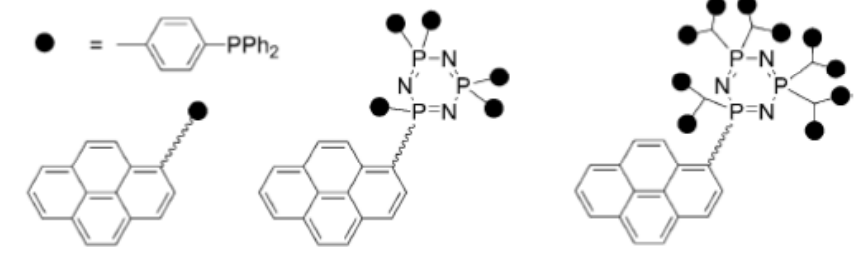
Figure 4. Structures of dendritic phosphine ligands. Reproduced from M. Keller et al . [55]. Copyright © 2013 WILEY-VCH Verlag GmbH & Co. KGaA,